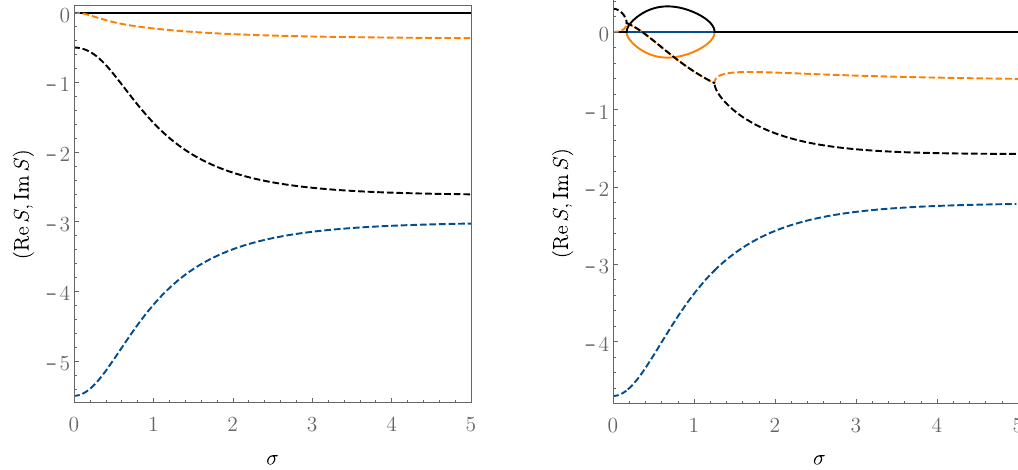
Figure 15: Three solutions (orange, black, blue) to (147) as a function of σ . The real part of S is in solid lines and the imaginary part of S is in dashed lines. We use z “ 5 { 2, b “ 2 and E “ 3 for the left figure and E “ 2.2 for the right. At large ? σ the physical saddle (orange) should approach ´ i { 2 p E ´ E 2 ´ b 2 q « ´ 0.382i for the left and ´ 0.642i for the right plot, as can be seen from the plots. Notice that the physical saddle approaches S “ 0 for σ “ 0 as claimed in the main text, whereas the other saddles indeed approach S “ ´ i p E ˘ z q . Near σ “ 8 one saddle (blue) approaches the value S “ ´ i E corresponding with (64) and another (black) ? E 2 ´ b 2 q , the other standard solution in (62). For the right approaches ´ i { 2 p E ` plot, we can see that E “ 2.2 enters the cut when the physical saddle and one of the other saddles coincide, it leaves the cut again at the second bifurcation. Both these transitions take place at an (anti-)Stokes line, as claimed in the main text, since both the real and imaginary parts of the saddles coincide. In the region between the two bifurcations, both saddles are on the integration contour, otherwise only the physical one is included